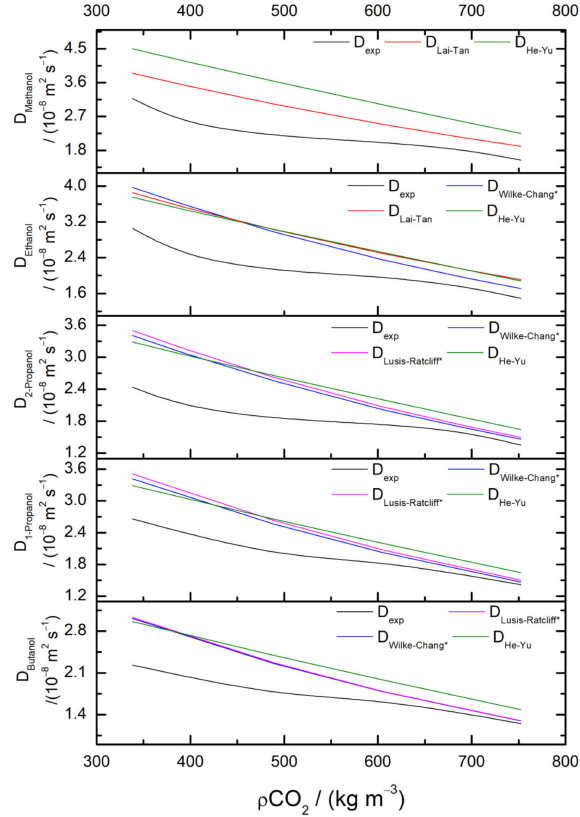
Figure 3. Experimental and predicted diffusion coefficients for methanol, ethanol, 1-propanol, 2- propanol, and 1-butanol in scCO 2 at pressure p = 10.5 MPa and at temperatures from 306.15 to 331.15